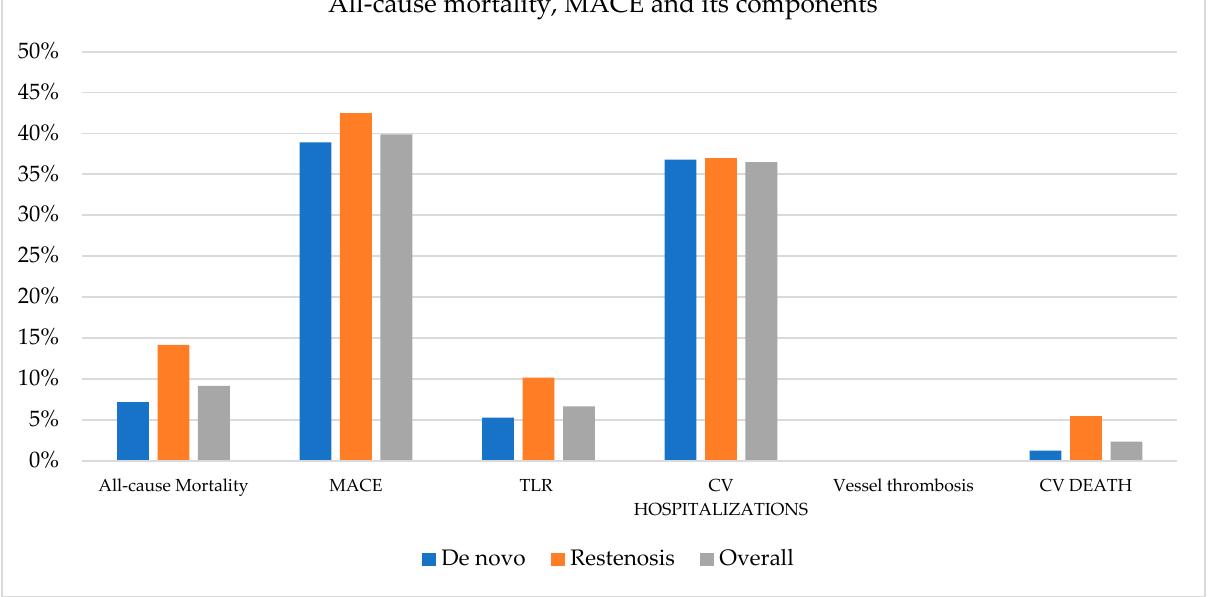
Figure 1. All-cause mortality, MACE and its components. MACE = major adverse cardiac events; TLR = target lesion revascularization; CV = cardiovascular.